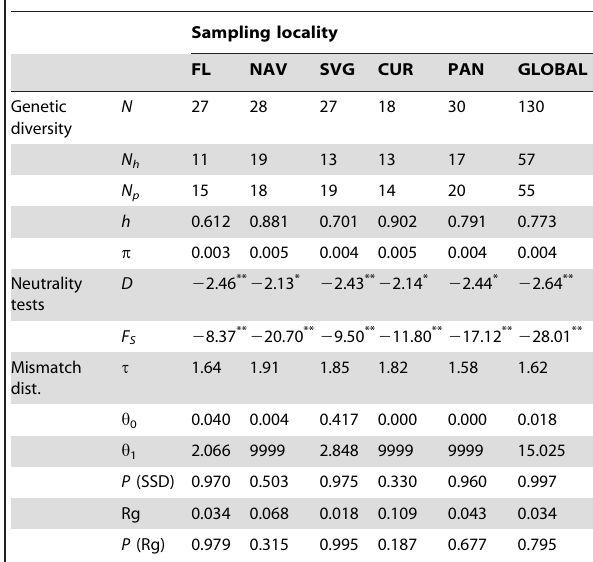
Table 2. Genetic diversity indices, neutrality test statistics, and mismatch distribution parameters for mitochondrial cyt